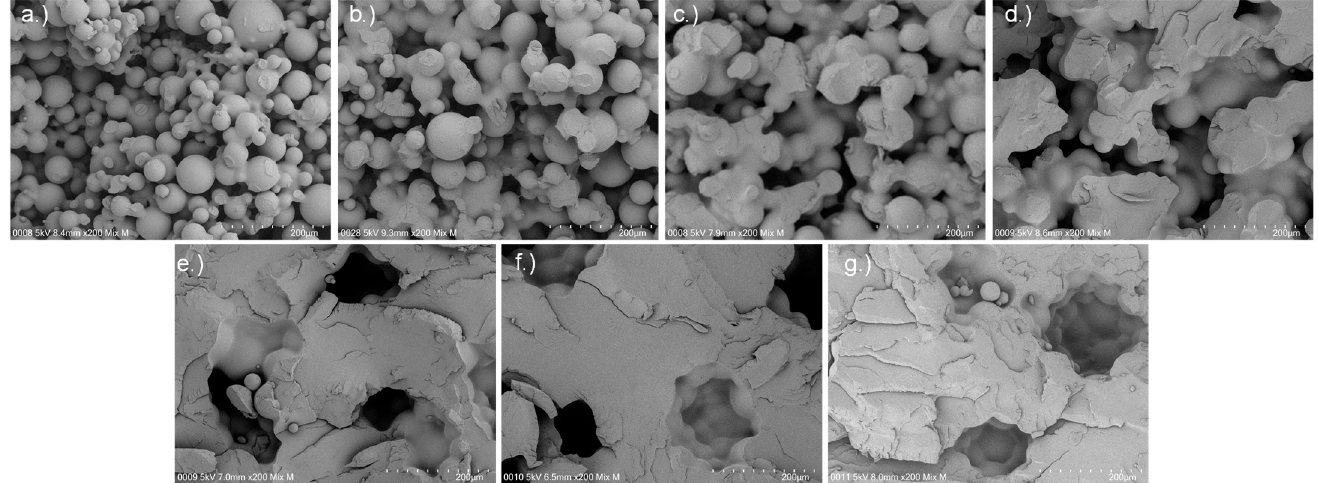
Figure 7. SEM micrographs at 200× magnification from the broken edge of tensile test specimen with different binder loadings: ( a ) 5 wt%; ( b ) 10 wt%; ( c ) 15 wt%; ( d ) 20 wt%; ( e ) 25 wt%; ( f ) 30 wt%; ( g ) 45 wt%.